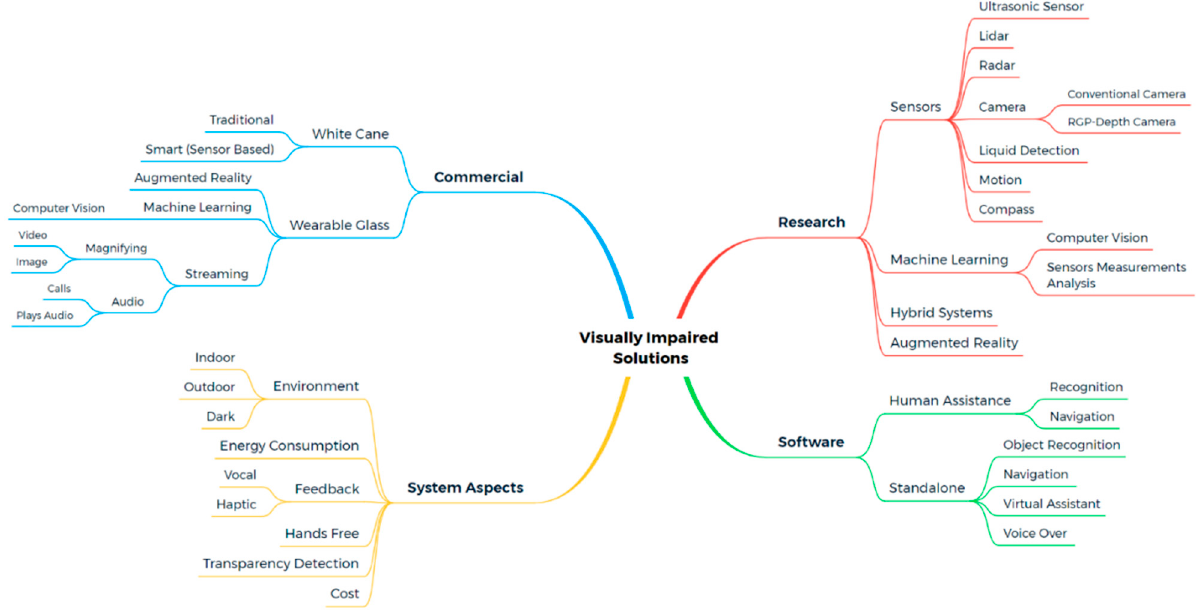
Figure 1. A Taxonomy of Visually Impaired Solutions.